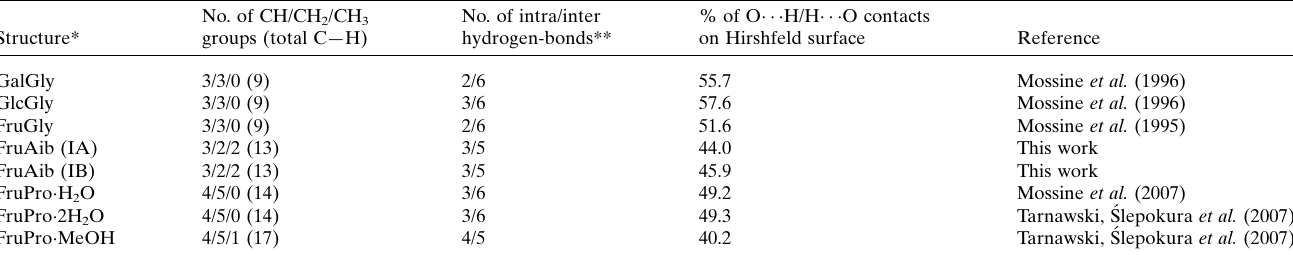
Table 3 Hydrogen bonding and contributions of the O (cid:5)(cid:5)(cid:5) H/H (cid:5)(cid:5)(cid:5) O contacts to the Hirshfeld surfaces of sugar-amino acids. Notes: (*) All sugar-amino acids are in the pyranose form and all have four hydroxy, one carboxyl and one ammonium group, and one pyranose ring oxygen; (**) hydrogen-bond selection criteria: D (cid:5)(cid:5)(cid:5) A < 2.9 A˚ ; H (cid:5)(cid:5)(cid:5) A < 2.7 A˚ ; D —H (cid:5)(cid:5)(cid:5) A >95 (cid:3) .